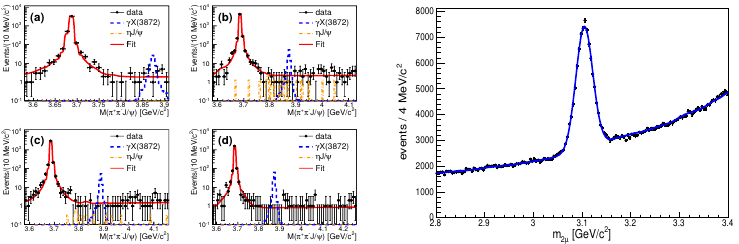
Figure 3. (Left) Fit to the distribution of M ( π + π − J /ψ ) [25]. (Right) Fit to the distribution of m µ + µ − [26]. The solid line is the fit result. The dots with error bar are the data. The lines present the fit